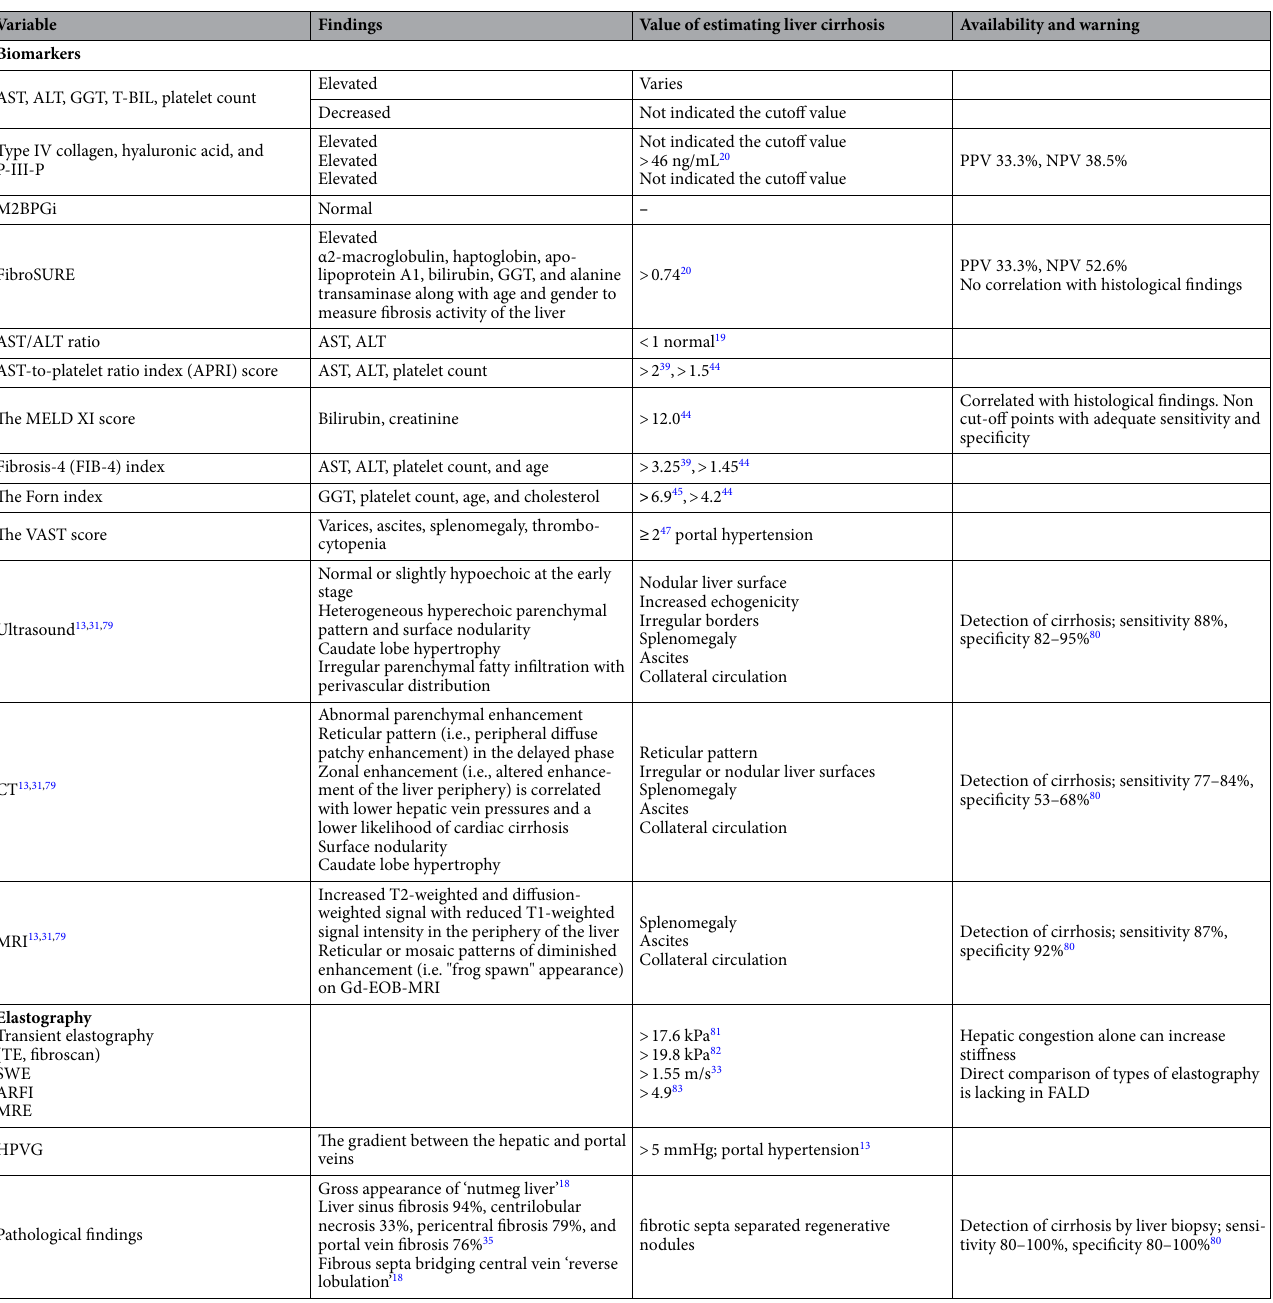
Table 2. Non-invasive and invasive assessment of FALD. ALT alanine aminotransferase, ARFI acoustic radiation force impulse, AST aspartate aminotransferase, CT computed tomography, FALD